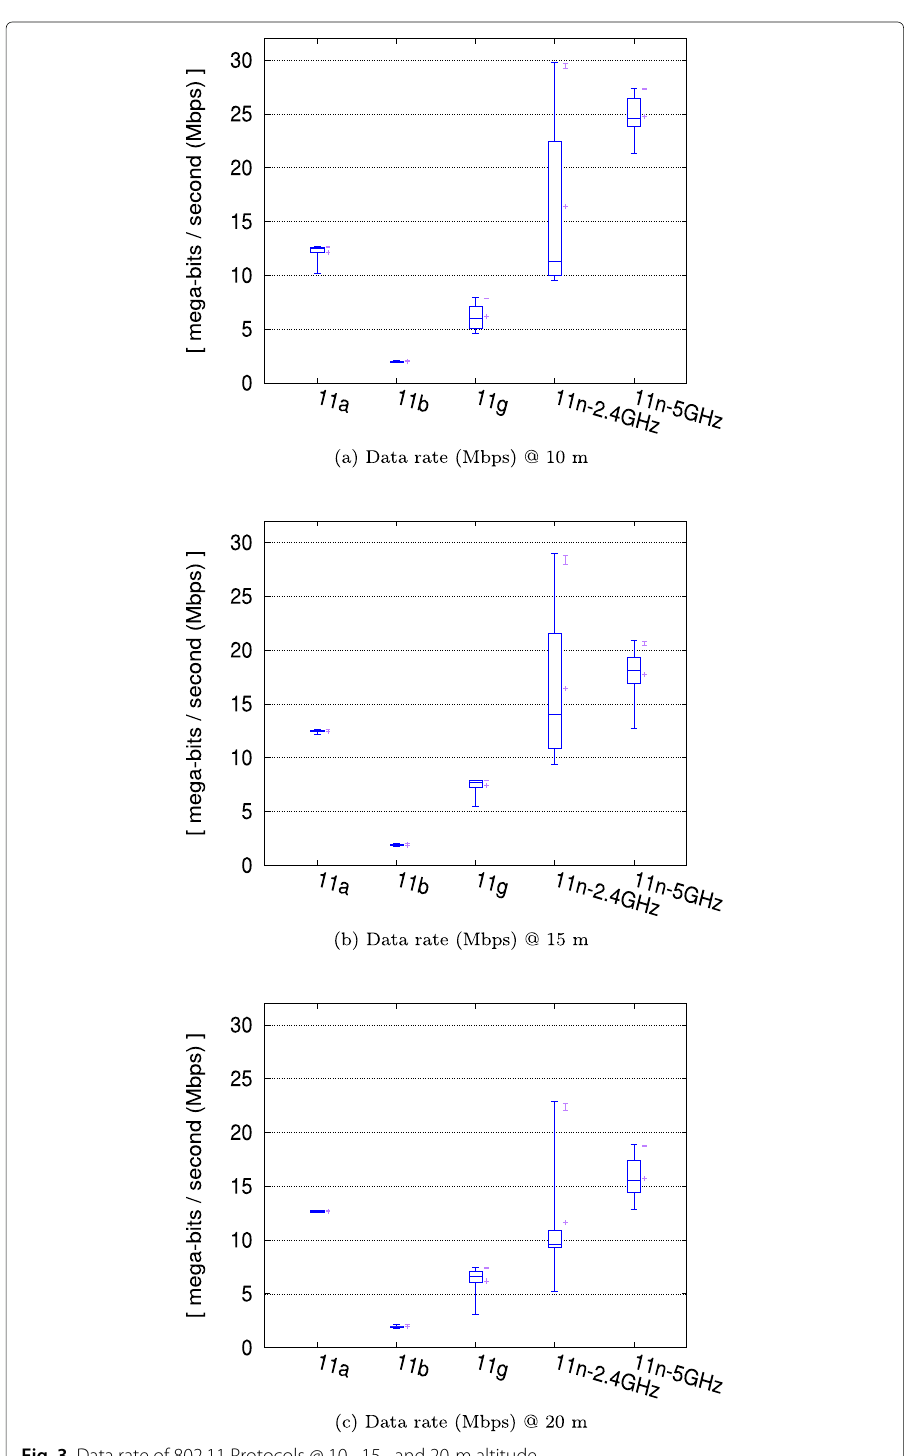
Fig. 3 Data rate of 802.11 Protocols @ 10-, 15,- and 20-m altitude